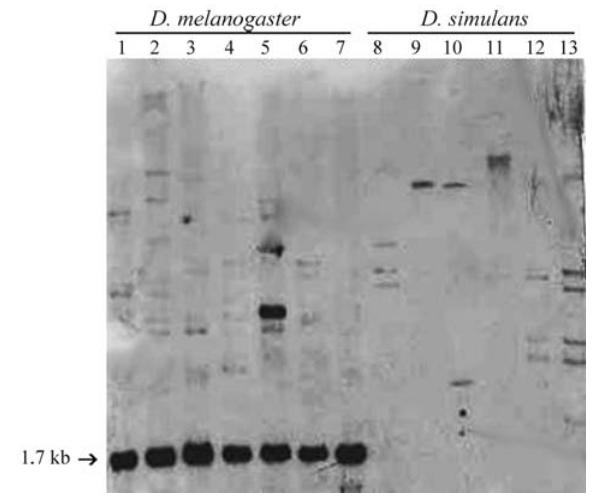
Figure 4 - Hybridization of 703 bp probe homologous to Bari-I internal sequence with genomic DNA of Drosophila melanogaster and D. simulans Brazilian populations after cleavage with Hind III restriction endonuclease. Lanes are as follows: 1-7: 1, D. melanogaster IN(1)AB; 2, TE (Teresina, PI); 3, SL (São Luís, MA); 4, SR (Santana do Riacho, MG); 5, NH (Novo Horizonte, SP); 6, MA (Maringá, PR); 7, SM (Santa Maria, RS); 8-13: D. simulans ; 8, D. simulans C167.4; 9, BG (Bento Gonçalves, RS); 10, MA (Maringá, PR); 11, NH (Novo Horizonte, SP); 12, GO (Goiânia, GO); 13, MN (Manaus,